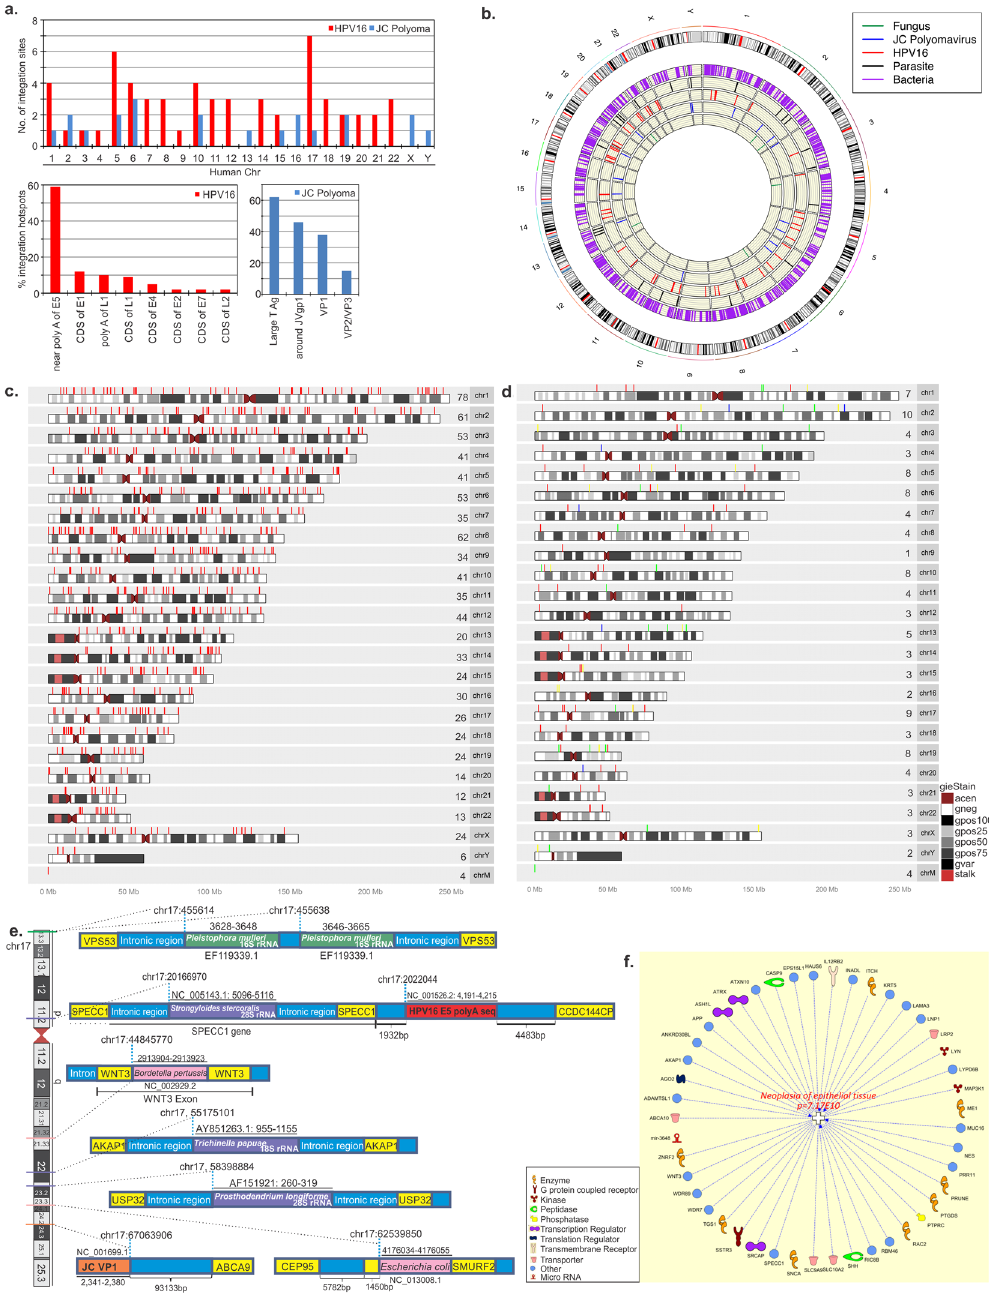
Figure 6. Microbial genomic integrations in the host chromosome. ( a ) Bar graphs showing number of viral (HPV16 and JC Polyomaviral) integration sites in host human chromosomes and the percentage of viral genomic sites for integration into host chromosomes. ( b ) Circos plot highlighting fusion events with >= 20 reads support for the bacterial, fungal and parasitic insertions into individual human chromosomes are shown. For the viral insertions, all the reads were taken into account. ( c ) Karyogram plot of bacterial insertion sites (red lines) in human chromosomes, cut off reads >= 20. The number of insertion sites in each chromosome is mentioned in the figure before chromosome number. ( d ) Karyogram plot of virus, parasite, fungus, insertion sites in human chromosomes. Color profile: green lines for parasite genomic insertional sites, red for HPV16, yellow for JC Polyomavirus, blue for fungus. The cutoff read for bacteria, fungus and parasite, >= 20 and for virus, all the insertion sites were included. The number of insertion sites in each chromosome is mentioned in the figure before chromosome number. G-banding annotation for each chromosome is shown; gneg - Giemsa negative bands; The Giemsa positive bands have further been subdivided into gpos25, gpos50, gpos75, and gpos100 with the higher number indicating a darker stain; acen - centromeric regions; gvar - variable length heterochromatic regions; stalk - tightly constricted regions on the short arms of the acrocentric chromosomes ( e ) Schematic representation of viral and microbial genomic insertional sites in human chromosome 17. The genomic co-ordinates of the pathogens integrated and that of the host chromosome integration sites